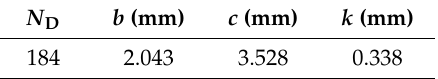
Table 1. The geometry parameters of